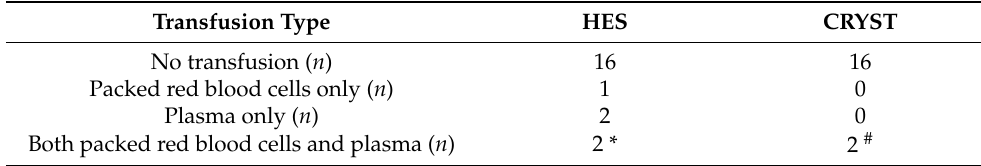
Table 1. Blood transfusions administered during hospitalization to dogs randomized to receive 6% hydroxyethyl starch 130/0.4 (HES) or Hartmann’s solution (CRYST). All transfusions were administered after study enrollment. Transfusion Type HES CRYST No transfusion ( n ) 16 16 Packed red blood cells only ( n ) 1 0 2 0